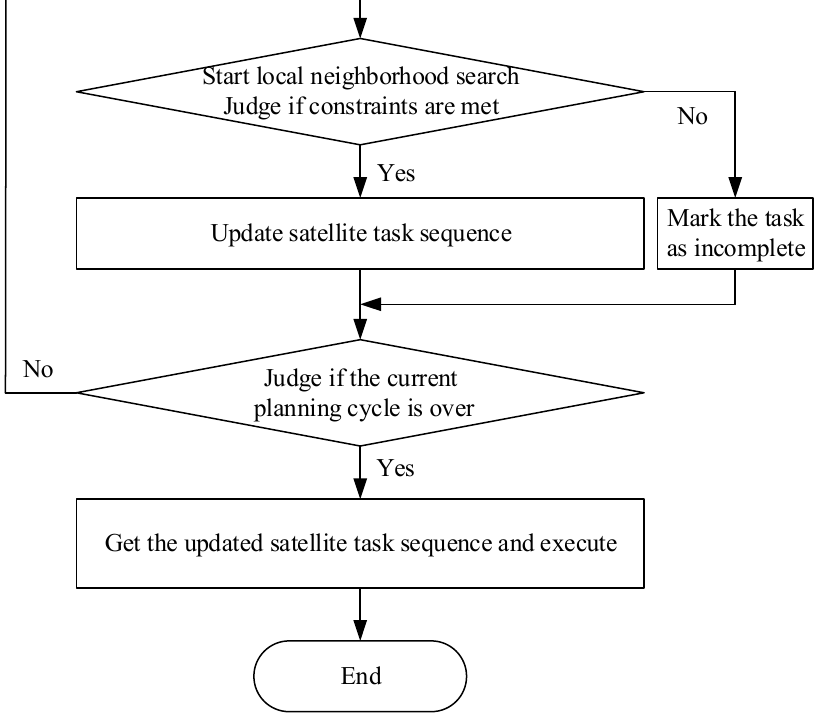
Figure 4. Flowchart of the onboard autonomous planning algorithm.